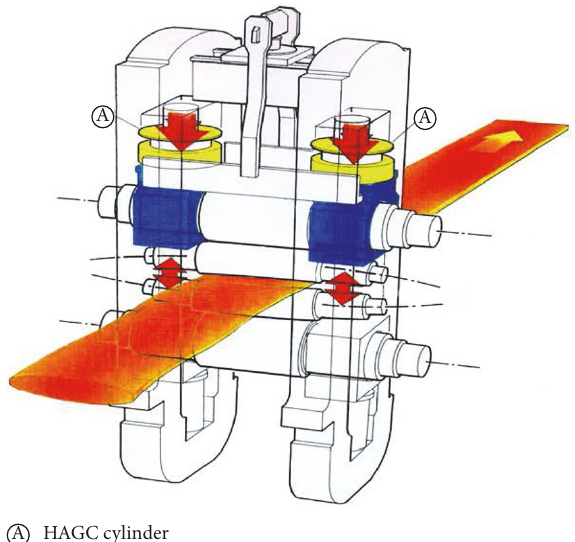
Figure 1: The mechanical structure of finishing mill stand.